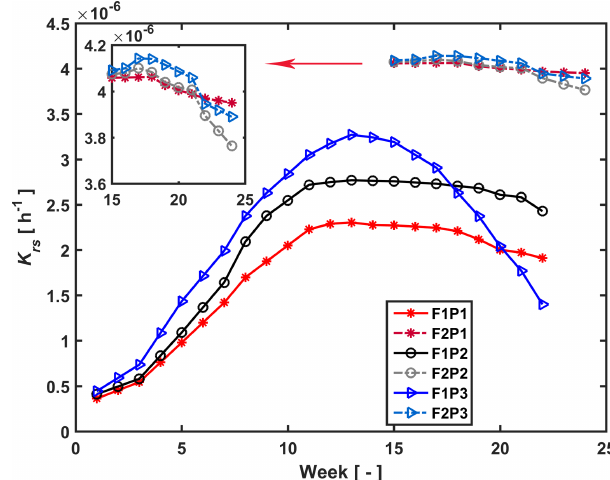
Figure 7. Estimated root hydraulic conductance ( K rs ) in the three plots (P1: sheltered; P2: rainfed; P3: irrigated) of the stony (F1) and silty (F2) soils during the measurement period (F1: from 11 Febru- ary to 11 July 2014, F2: from 23 May to 24 July